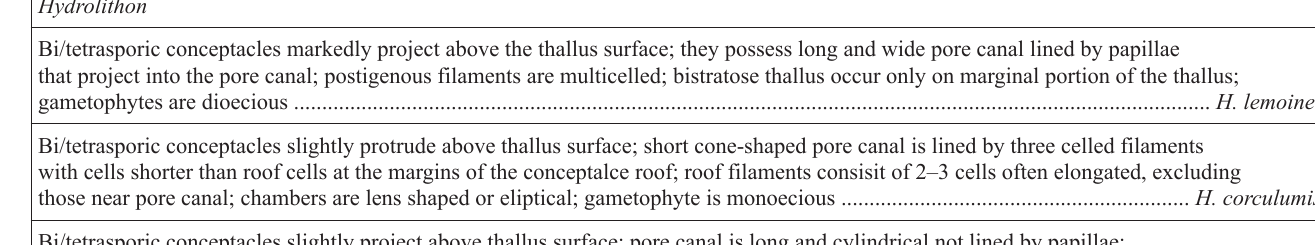
Table 3. Identification key for the genera Hydrolithon and Lithoporella from the central Paratethys. Bi/tetrasporic conceptacles uniporate with roof formed by cells perpendicularly oriented to the chamber; dimerous construction and primigenous filaments without palisade cells; trichocytes are not arranged in large tightly packed horizontal fields.................. ..Hydrolithon Bi/tetrasporic conceptacles uniporate with roof formed by cells perpendicularly oriented to the chamber; dimerous construction and primigenous filaments with palisade cells; Trichocytes are not arranged in large tightly packed horizontal fields ..................... Lithoporella